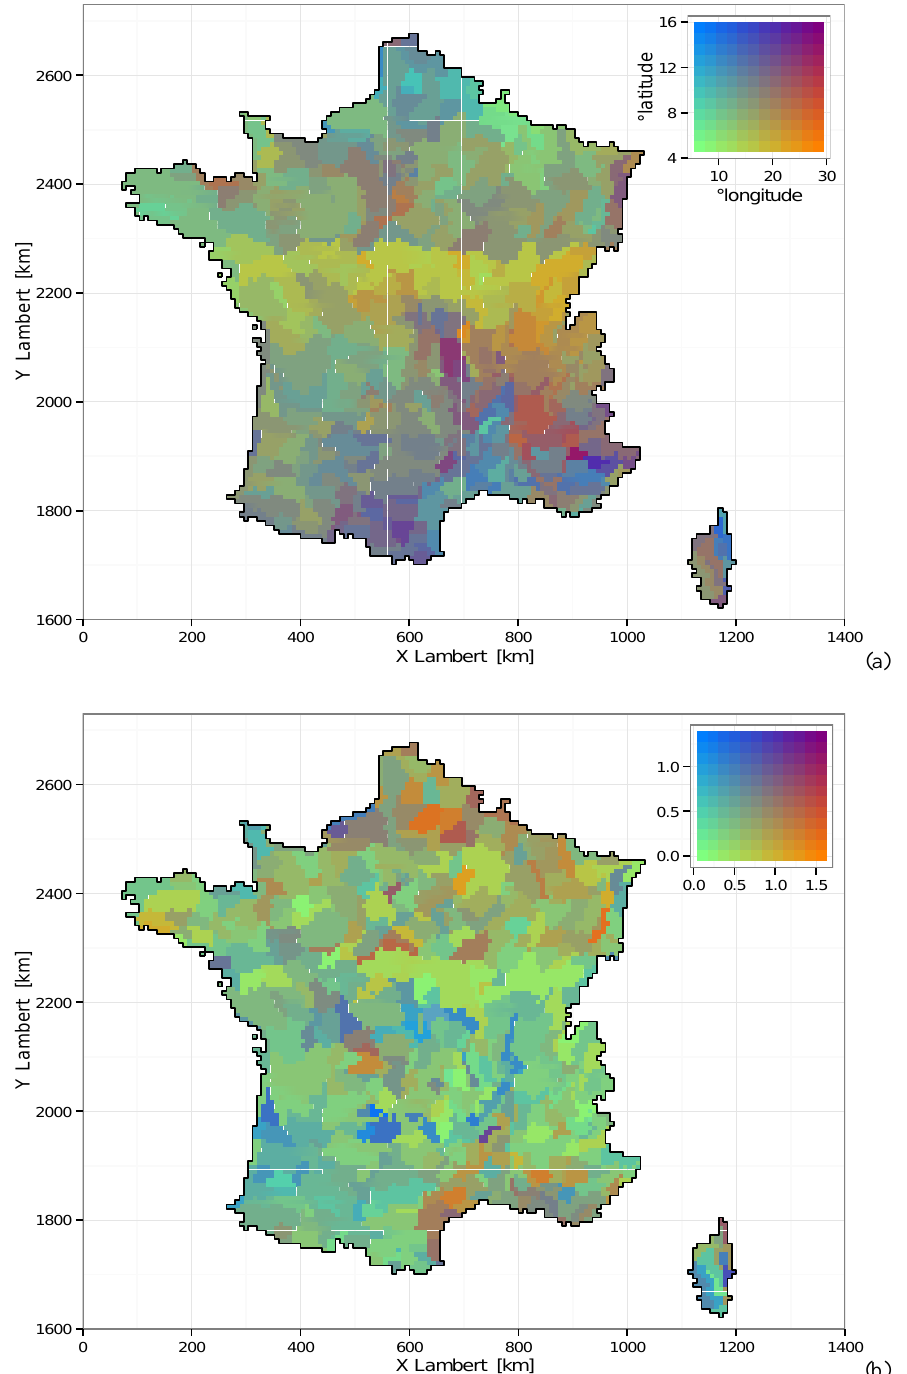
Fig. 7. (a) Mean domain size of the five best domains found during the optimisation procedure for each zone. The size is given in degrees longitude and latitude. Green, small domains; purple, large domains; blue, small in longitude direction and comparatively large in latitude direction; orange, large in longitude direction and small in latitude direction. (b) Ratio of domain size range in the five-domain ensemble (range/mean size). 0, no difference in domain extent; 1, the difference in extent between the largest and the smallest equals the medium